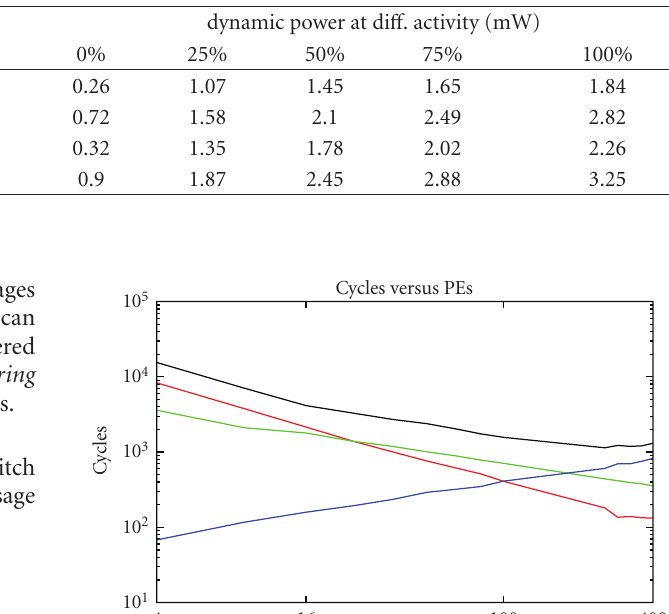
Table 3: NoC dynamic power model.